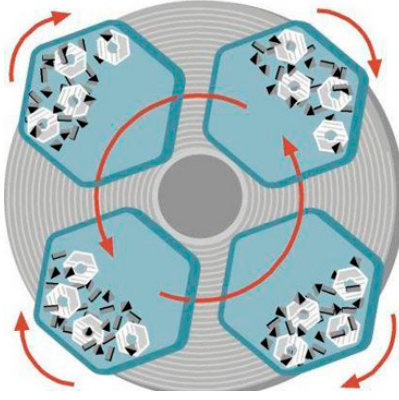
Figure 2. High-energy centrifugal barrel machine principle showing media and parts in each barrel.